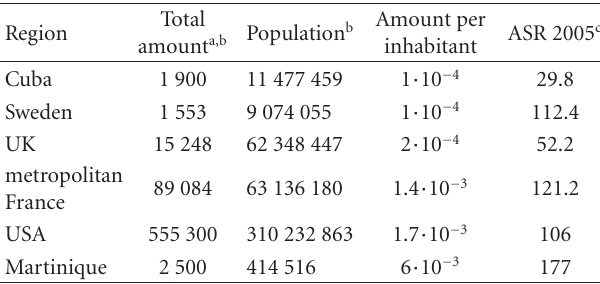
Table 2: Amounts of pesticides used in Martinique (in tons) in comparison with metropolitan France and other countries. Search for a correlation with the incidence rates of prostate cancer.